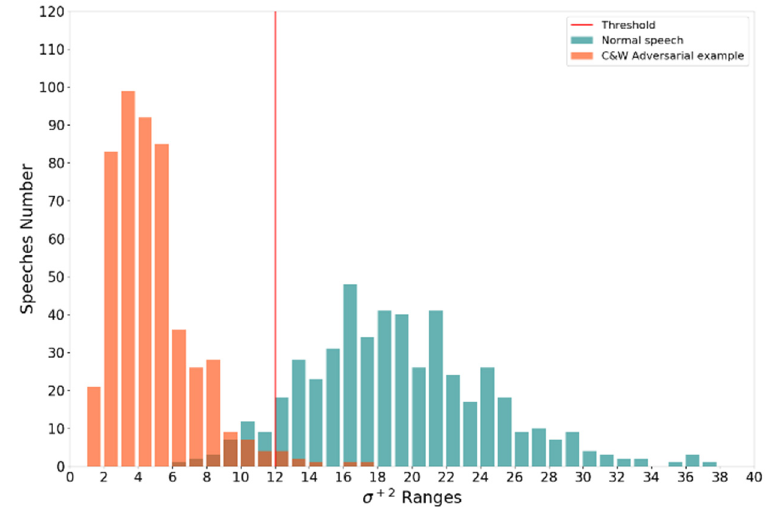
Figure 7. Detecting C&W adversarial examples by σ + 2 feature in Lingvo. The σ + 2 of C&W adversarial examples less than 12 can be correctly detected. A few normal speech values less than 12 are mistakenly judged as adversarial examples. There is a clear dividing line between this two. The threshold k = 12, is the σ + 2 dividing line between the adversarial example and normal